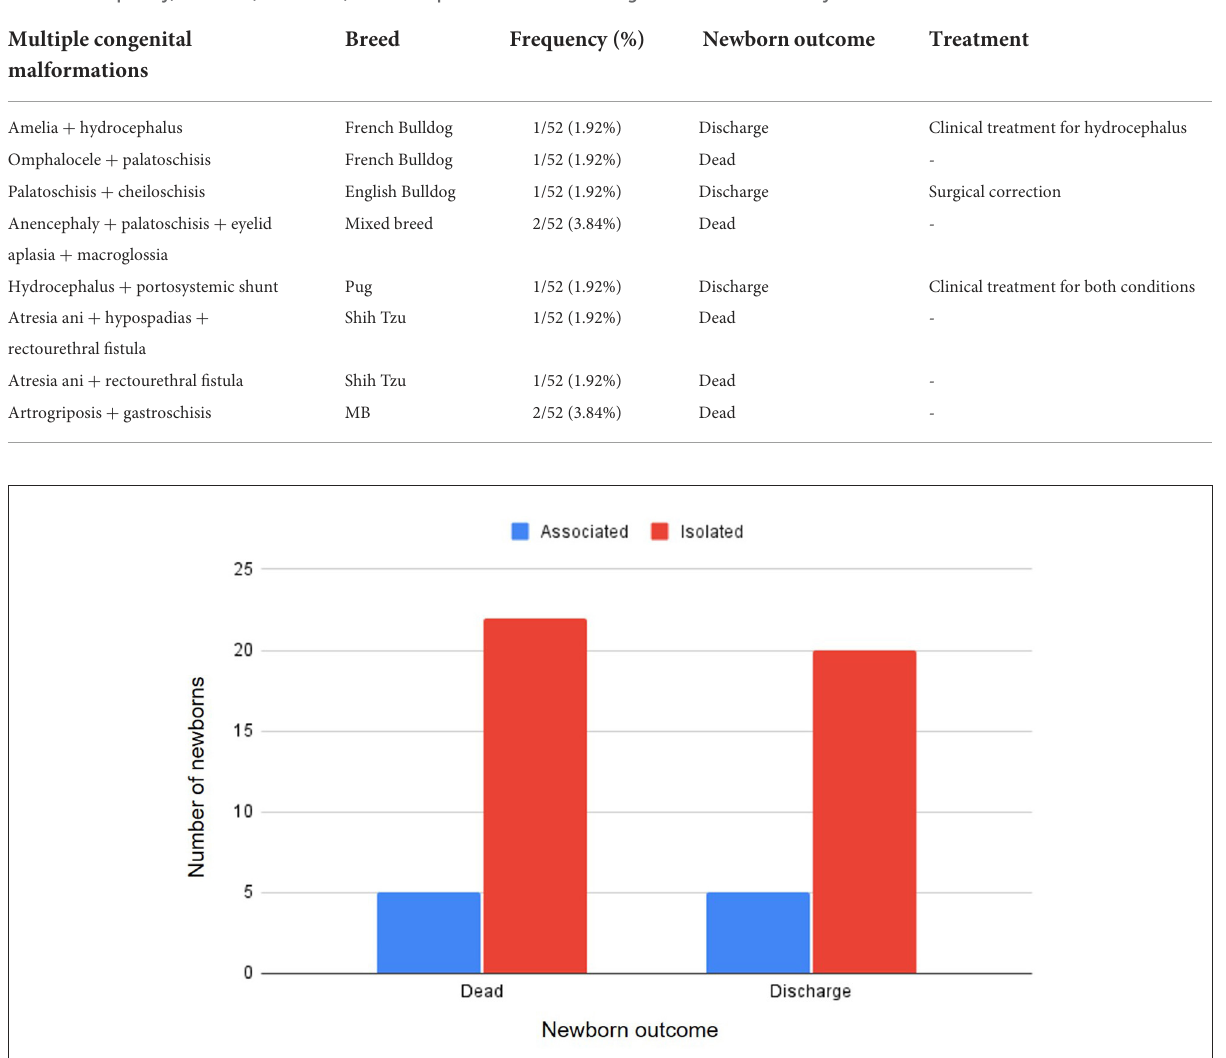
FIGURE3 Type of congenital anomaly (isolated or associated) and neonatal